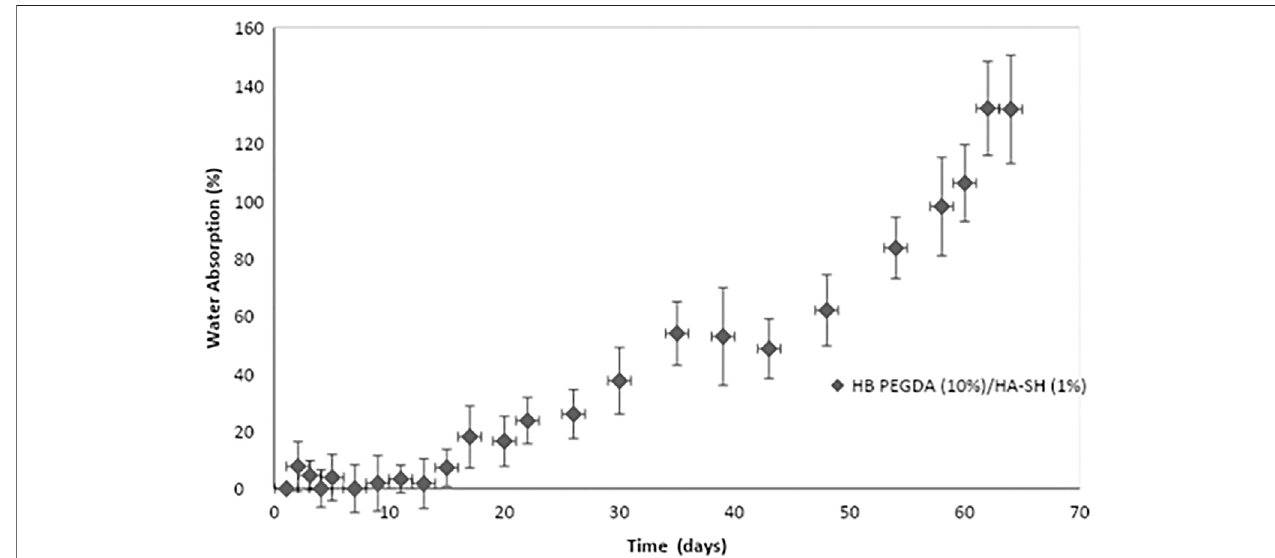
FIGURE3| WateruptakepercentageofHBPEGDA/HASH10.0 – 1.0hydrogelsasafunctionoftime.Testswereperformedusing theHBPEGDA/HASH 10.0 – 1.0 hydrogel (200 μ L) in 2 ml PBS solution at 37 ° C ( n (cid:2) 4).